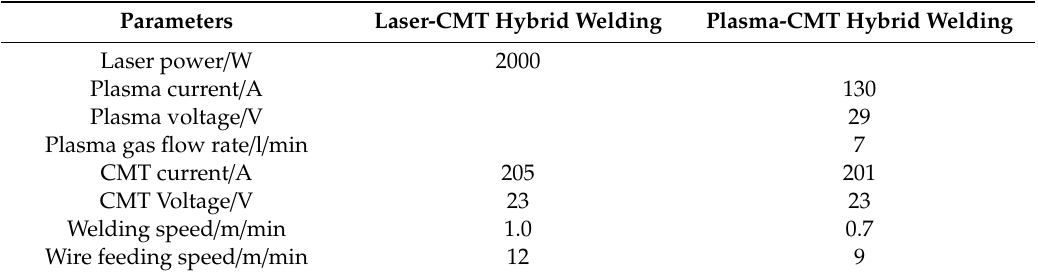
Table 2. The optimized welding parameters adopted in the hybrid welding process.